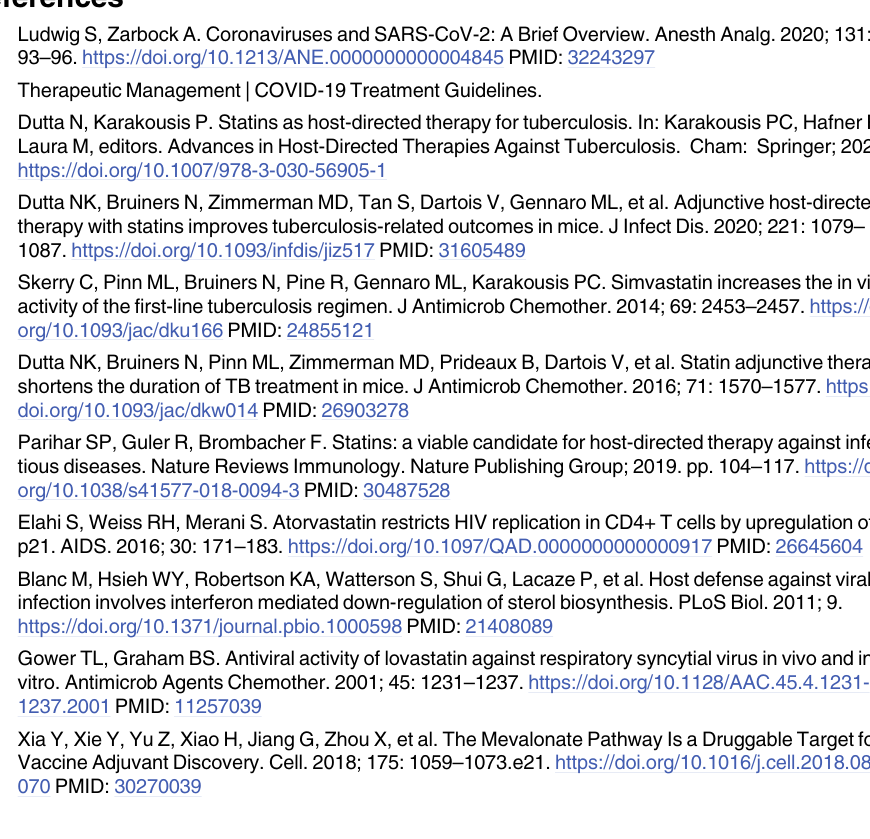
S4 Table. Means and variances in raw and balanced data for statin effect on severe COVID-19